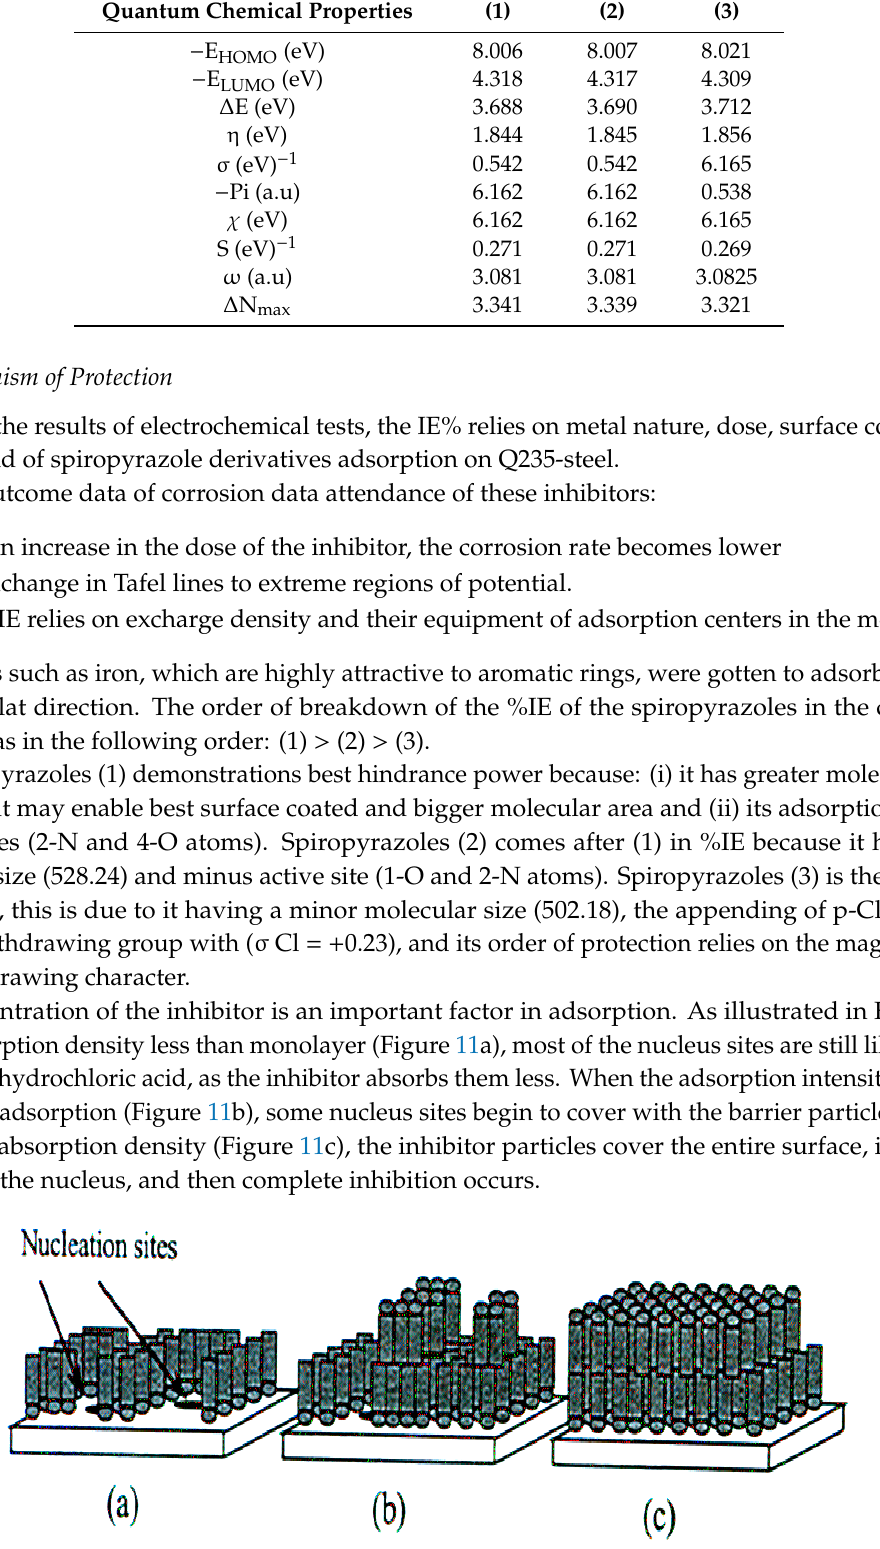
Figure 11. Adsorption diagrams for spiropyrazoles additives as inhibitors at: ( a ) Low concentration, ( b ) intermediate concentration, ( c ) high concentration on Q235 steel.